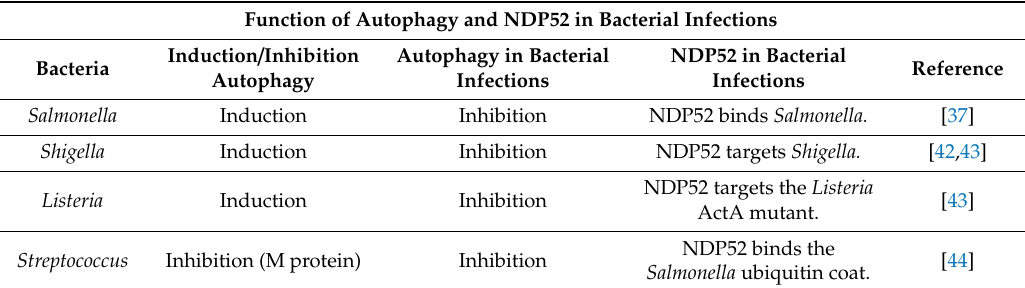
Table 1. Function of autophagy and NDP52 in bacterial